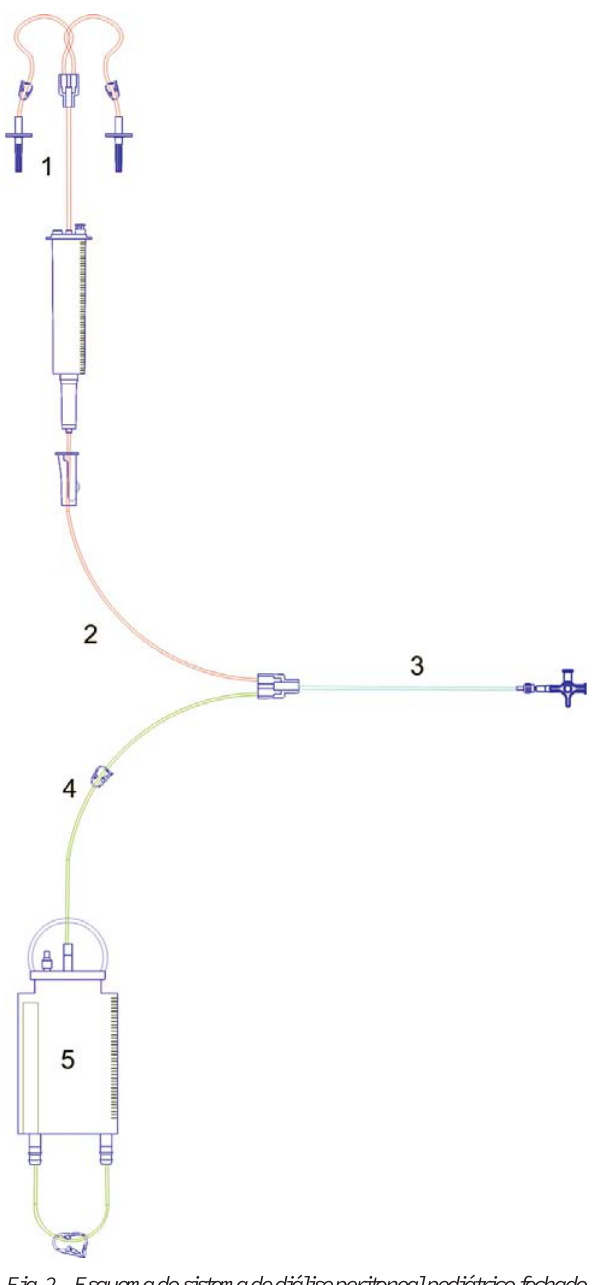
Fig. 2 – Esquema do sistema de diálise peritoneal pediátrico fechado indicando os locais em que foram inseridos os indicadores químicos